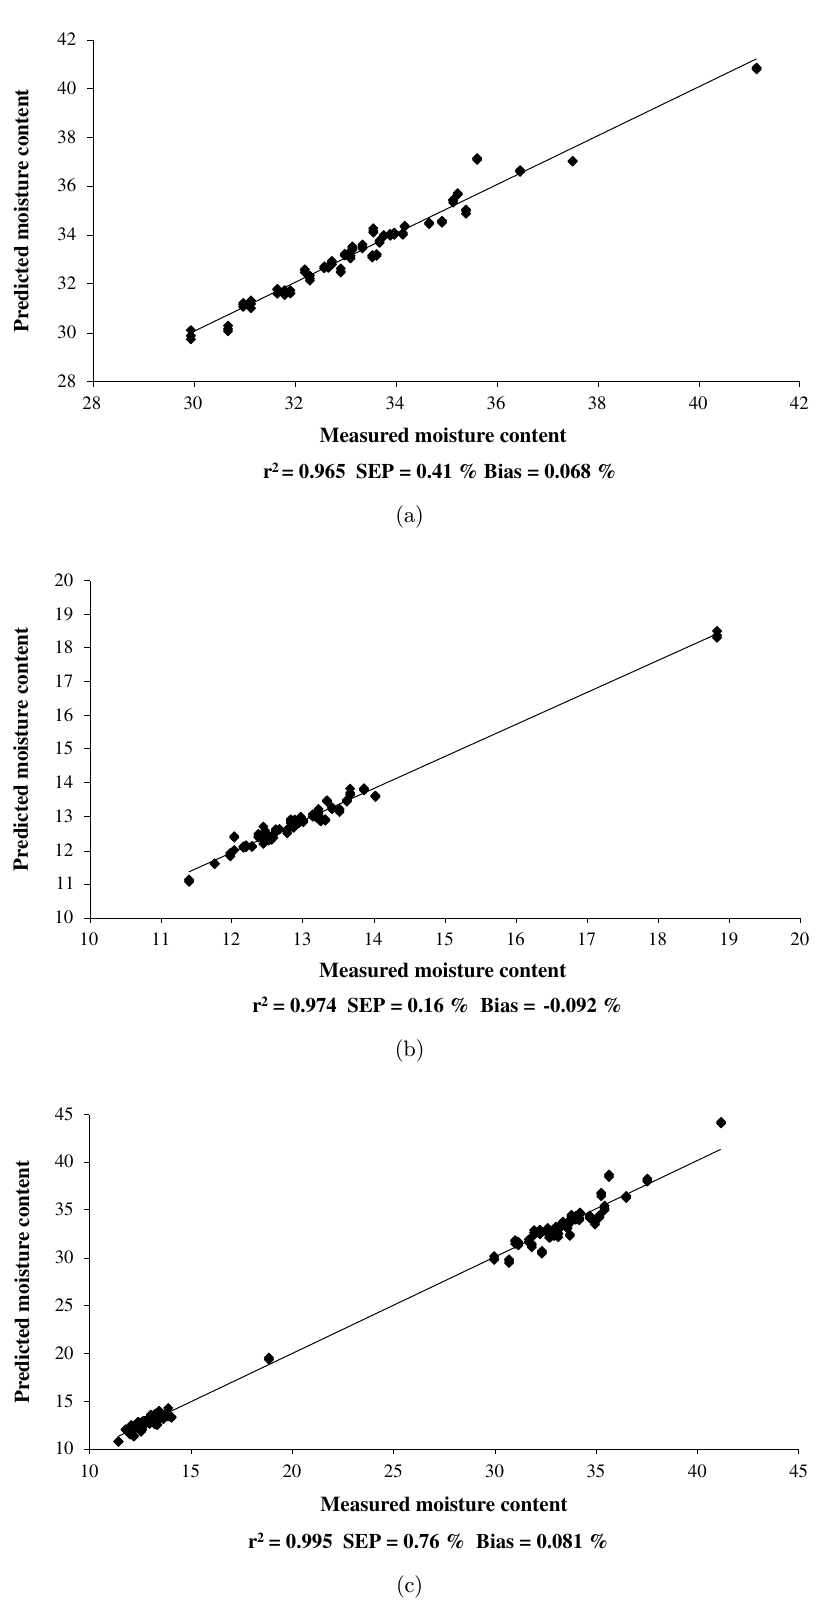
Fig. 4. Validation plots of measured moisture content (X) with predicted moisture content (Y) in tapioca starch samples. (a) Tapioca starch cake samples. (b) Dried tapioca starch samples. (c) Combined tapioca starch